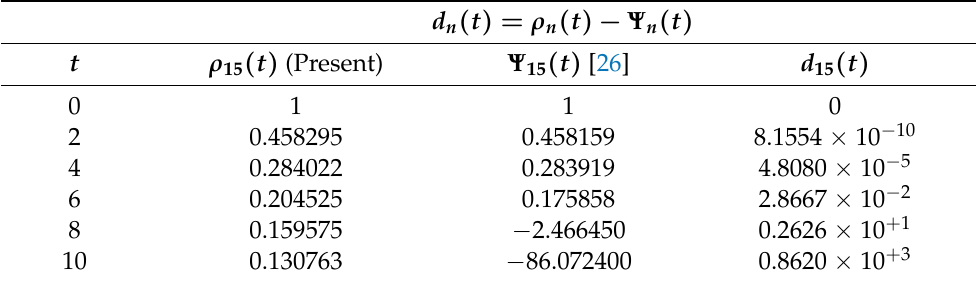
Table 3. Comparison between ρ 15 ( t ) (present), Ψ 15 ( t ) (Ref. [19]) when λ = 1, q = 2 and α =